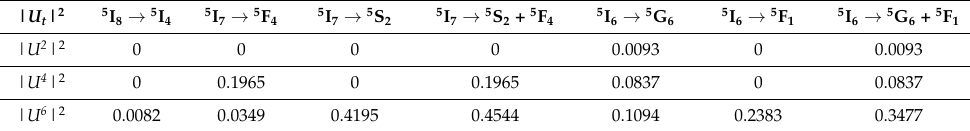
Table 6. Doubly reduced matrix elements for selected transitions in Ho 3+